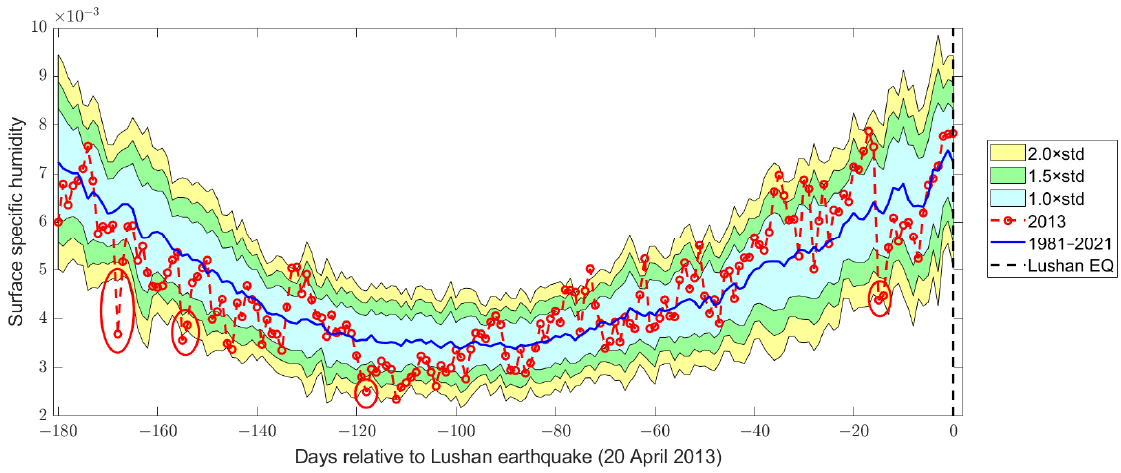
Figure 17. Surface specific humidity from the six months before the Mw 6.7 Lushan 2013 earthquake.